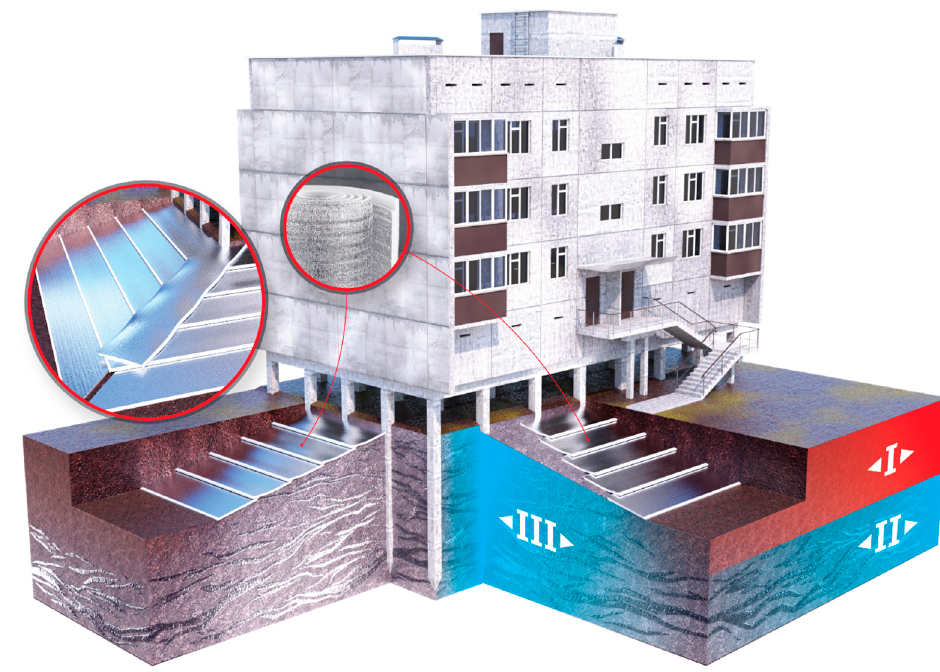
Figure 9. Scheme of insulation along the perimeter of the pile building: I—summer thaw layer; II—permafrost; III—permafrost is preserved in the whole depth.